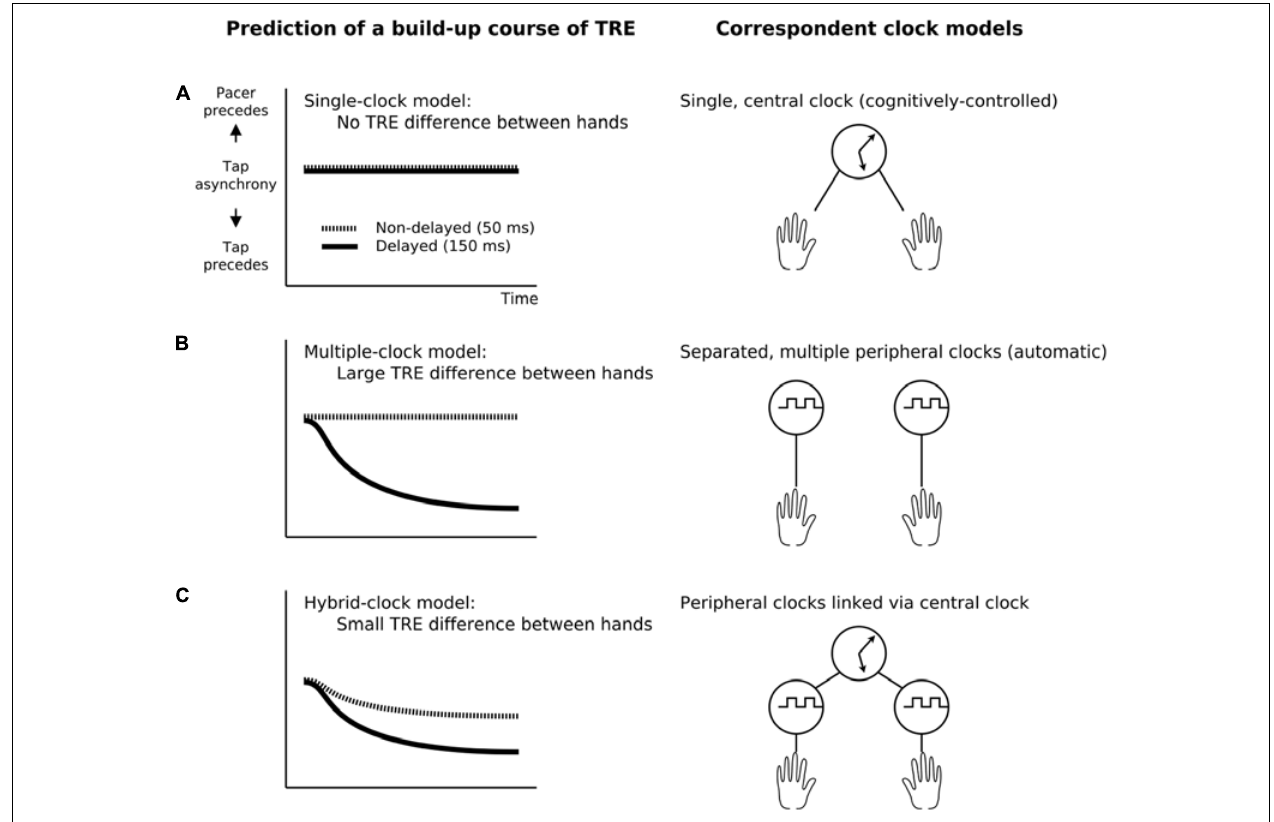
multiple-clock model assumes peripherally localized different clocks, predicting a TRE difference between hands as the hands are adapted separately via each clock. (C) The hybrid-clock model assumes both a central and peripheral clocks which are linked toghether, predicting smaller difference of the TRE than the multiple-clock model as the hands are adapted separately via peripheral clocks but cross-talked via a central